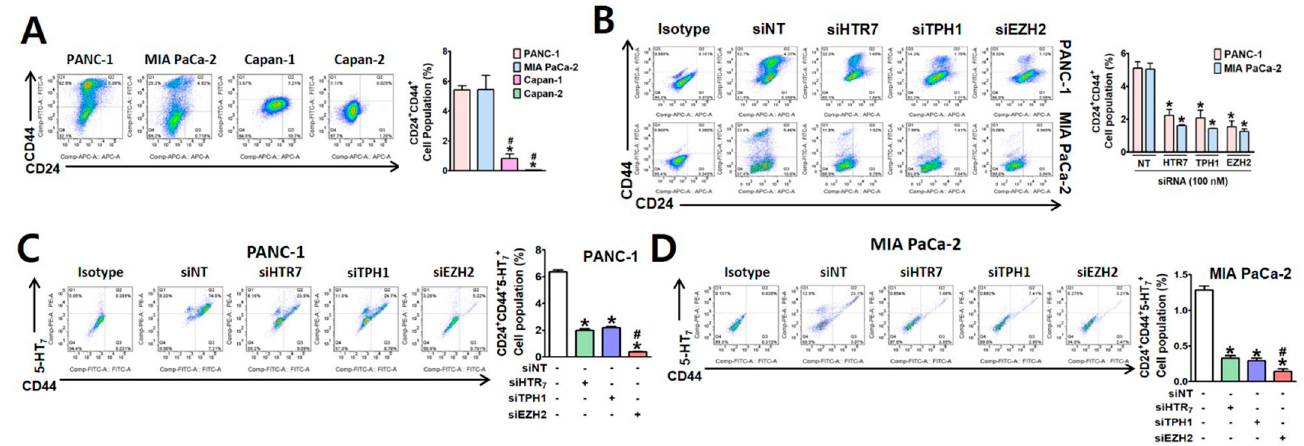
Figure 2. Effects of silencing 5-HT 7 , TPH1 and EZH2 on pancreatic CSC population. ( A ) PANC-1, MIA PaCa-2, Capan-1, and Capan-2 cells stained with antibodies specific to pancreatic CSC surface markers, CD44-FITC and CD24-APC, were analyzed by FACS. Bar graph indicates relative number of CSCs population (CD24 + CD44 + ) determined from three inde- pendent experiments. ( B ) Relative number of CD24 + CD44 + population after KD of HTR7, TPH1, or EZH2 in PANC-1 and MIA PaCa-2 cells. ( C , D ) The relative CSC population expressing CD24, CD44, and 5-HT 7 in PANC-1 ( C ) and MIA PaCa- 2 ( D ) cells after KD of HTR7, TPH1, and EZH2. * p < 0.05, compared to siNT-transfected group. # p < 0.05, compared to siHTR7- or siTPH1-transfected group.